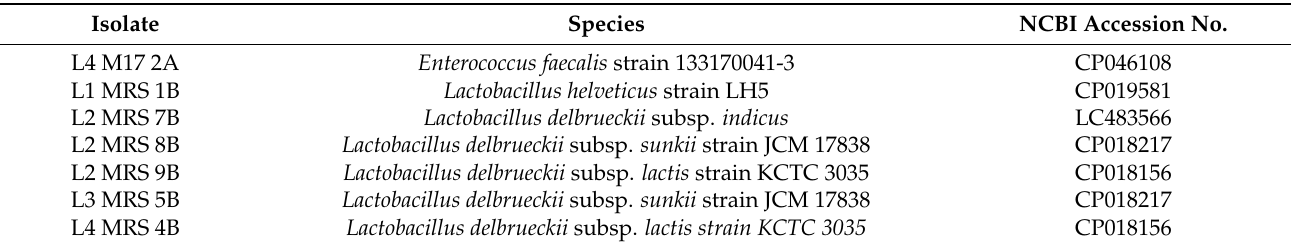
Table 4. Gene sequencing information from 16S